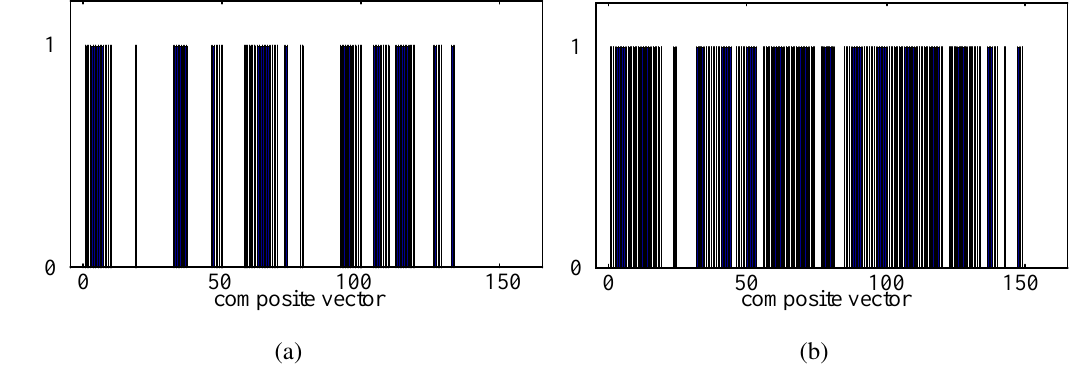
Figure 6. Distribution of the selected composite vectors. ( a ) 60 composite vectors. ( b ) 120 composite